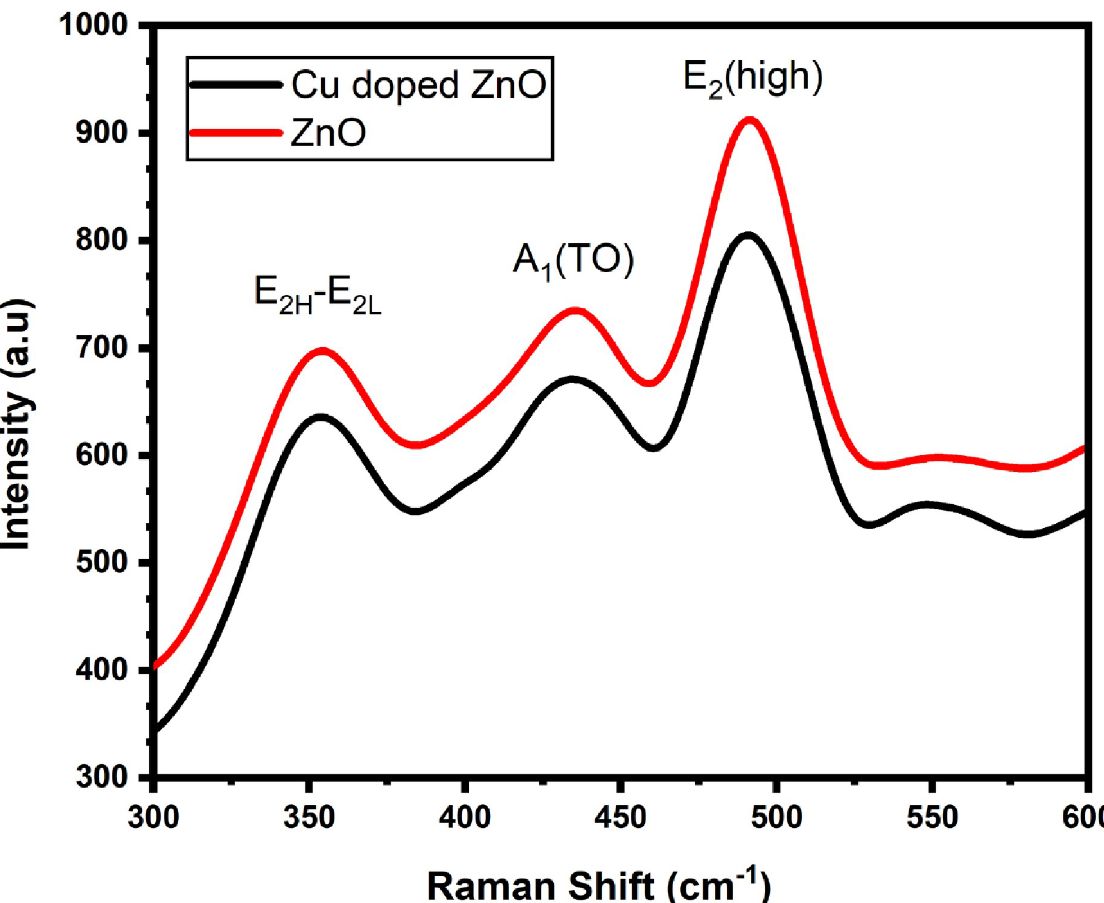
Fig 3. Raman spectrum of the as-synthesized ZnO and Cu-doped ZnO nanoparticles.